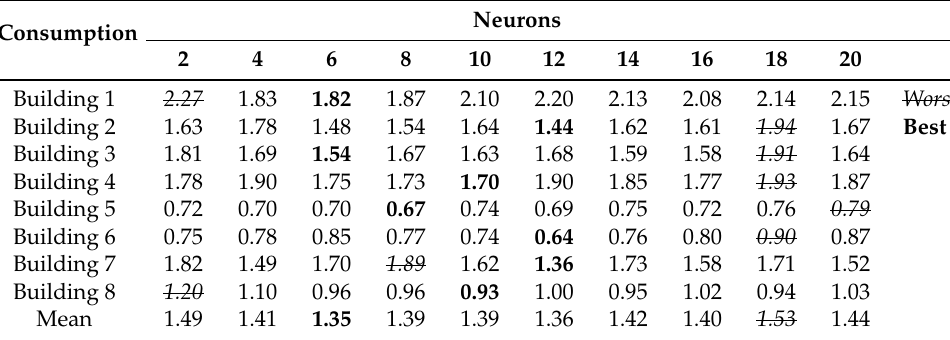
Table 2. MSE of the neurons parameter obtained with the NAR Table 1. MSE of the delay parameter obtained with the NAR model.